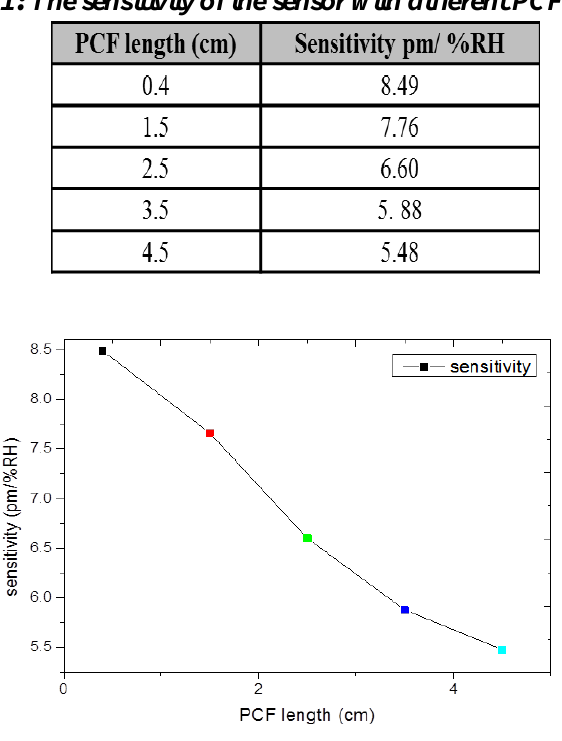
Fig. 8: The relationship between PCF lengths and sensitivity of the